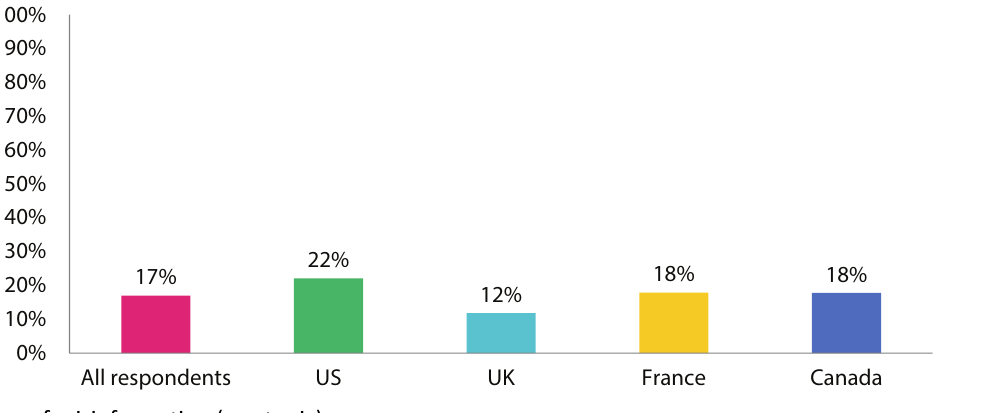
Figure 3. Sharing of misinformation (any